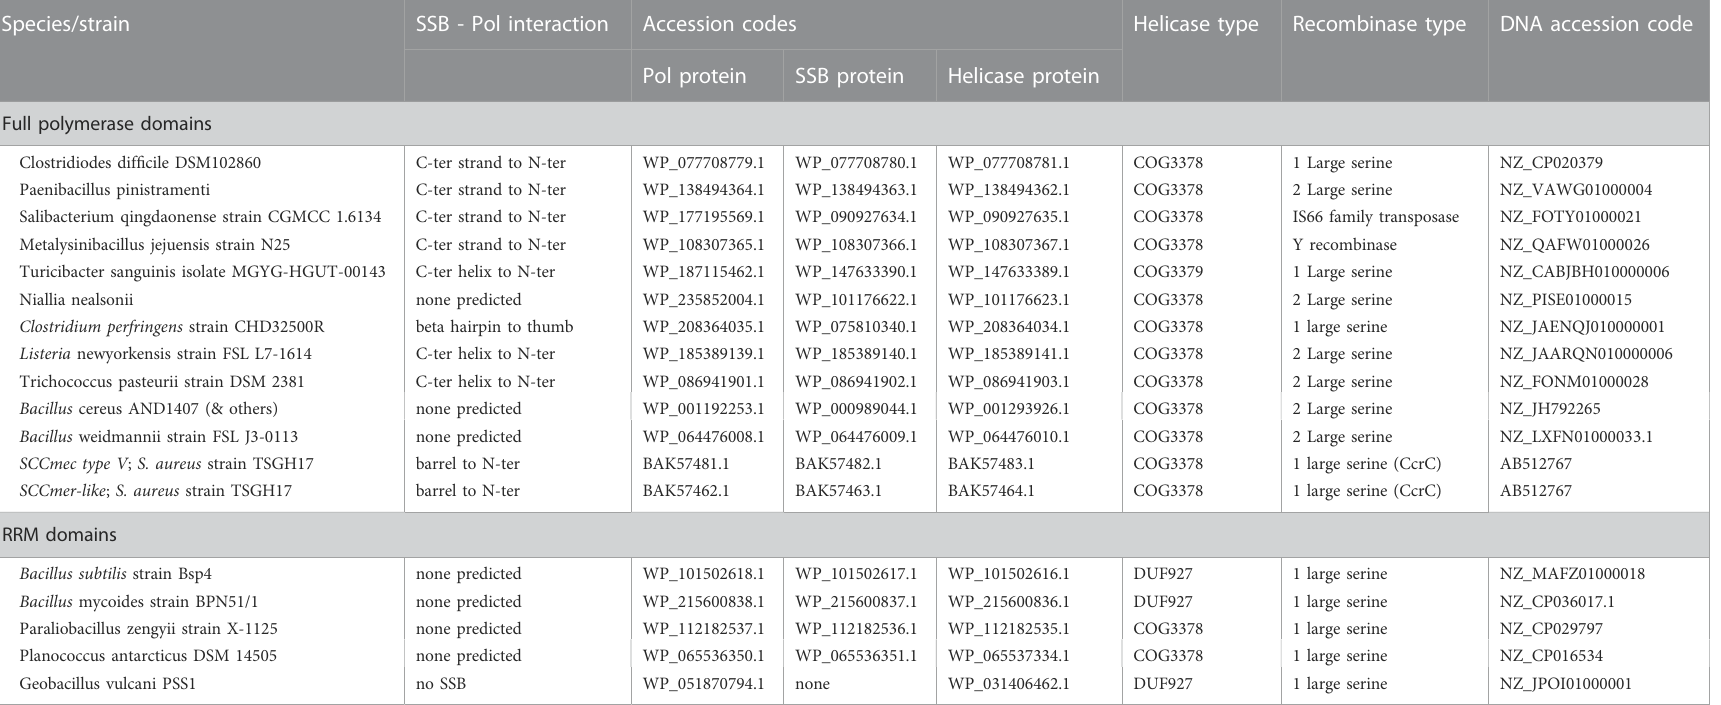
TABLE 1 Accession Codes and notes for Pol-SSB pairs